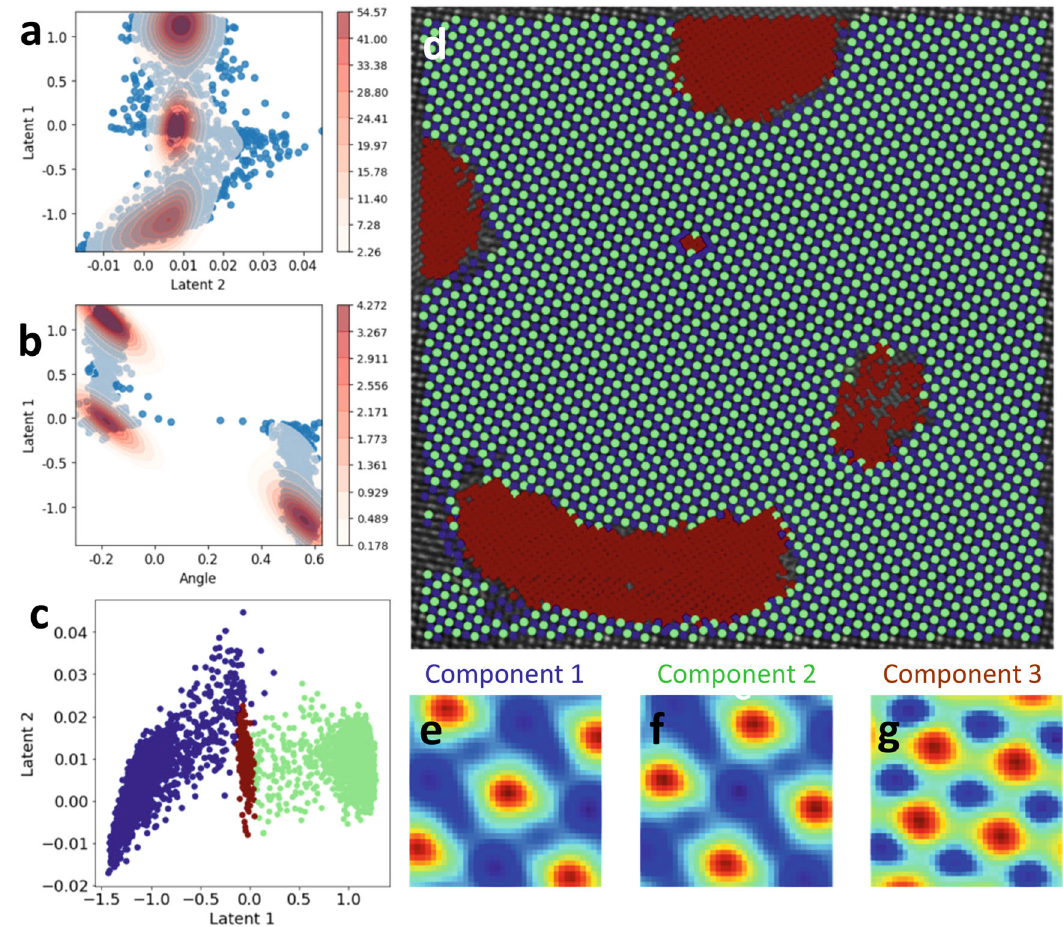
Fig. 4 Latent space distributions. Pair distribution for a latent variables and b encoded angle and fi rst latent variable. c Gaussian mixture model (GMM) clustering for latent spaces. d Original STEM image with superimposed class labels and GMM centroid images corresponding to four components used. e – g Three components: component 1 (dark blue), component 2 (green), component 3 (brown). Analysis performed on raw data using a window size of 36